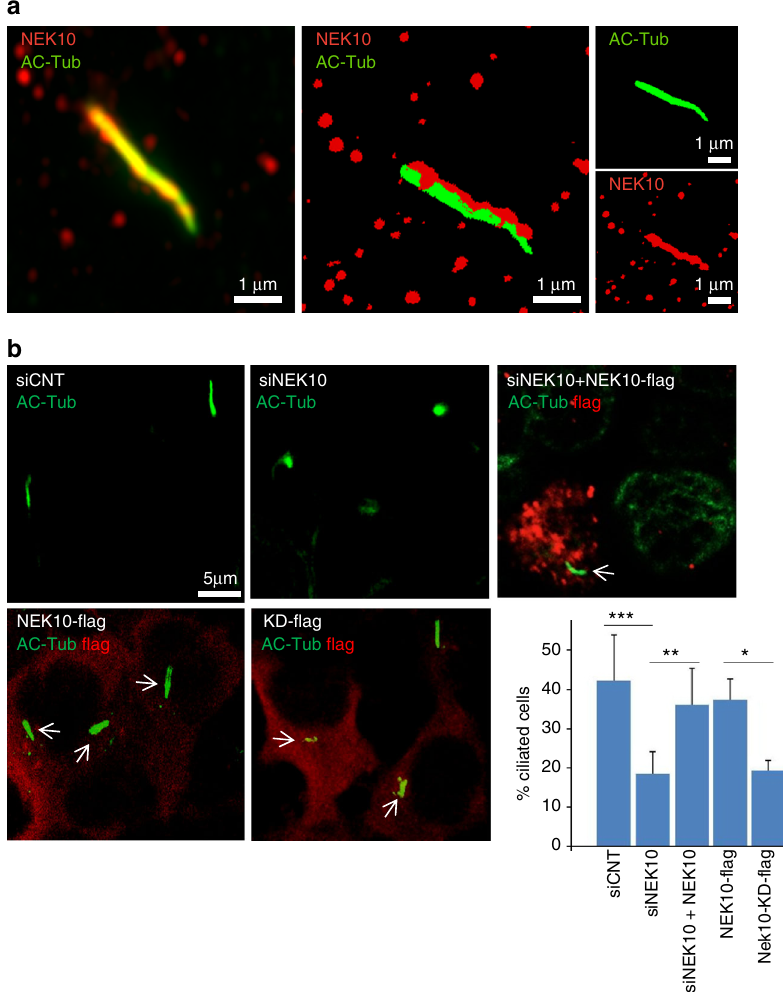
Fig. 2 NEK10 localization and regulation of primary cilium formation. a Serum-deprived HEK293 cells were immunostained for NEK10 and acetylated tubulin and analyzed by confocal microscope equipped with Airyscan superResolution imaging module. A merge composite 2D and 3D of the signals is shown. b HEK293 cells were transiently transfected with control (siCNT) or with siRNAs targeting NEK10 (siNEK10), serum deprived for 36 h, formalin- fi xed and immunostained for acetylated tubulin. Where indicated, NEK10- fl ag vector (either wild type or kinase dead, KD) was included in the siRNAs transfection mixture. NEK10 expression was visualized with anti- fl ag antibody. Arrows indicate the localtion of the cilium in cells expressing fl ag-tagged NEK10. Cumulative data from three independent experiments are shown (lower right panel). For each group a minimum of 100 cells/experiment was averaged. * p < 0.05; ** p < 0.01; *** p < 0.001 (Student's